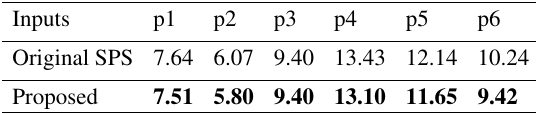
Table 1. bad2.0 comparisons before and after improved( %